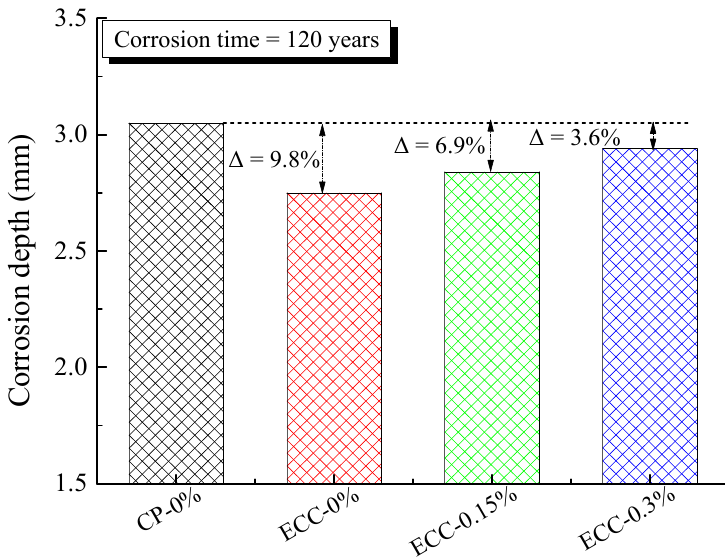
Figure 14. Predicted corrosion depth of soil nails exposed to chloride solution for 120 years.